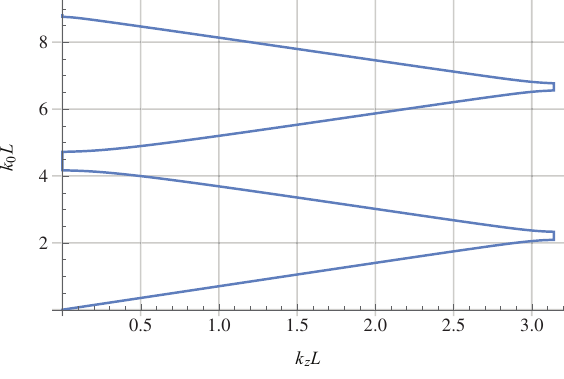
Figure 2. The band diagram for the 9th order fractal MTM. Four propagation bands and three band gaps are seen in the